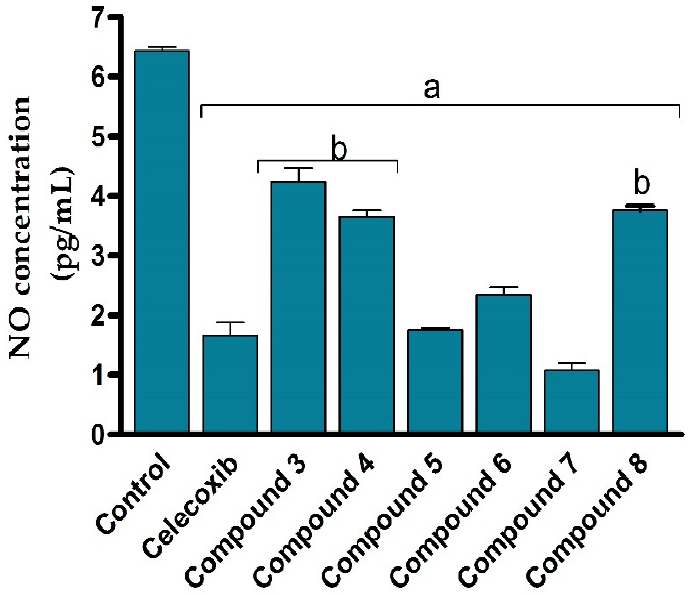
Figure 5. Anti-inflammatory effects of 2-thioxoimidazolidin-4-one derivatives ( 3 – 8 ) against LPS-induced murine cell line (RAW264.7) by evaluating NO production. Data are shown as mean ± SD. a p < 0.05 versus control cells and b p < 0.05 versus celecoxib.